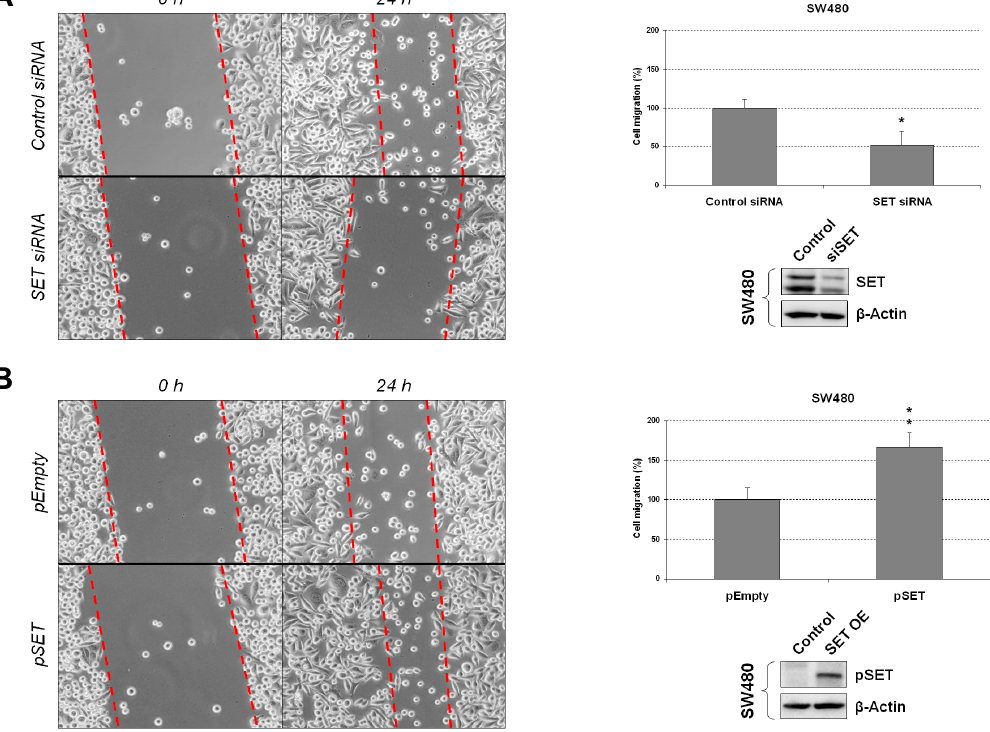
Figure 1. SET modulates cell migration in colorectal cancer (CRC) cells. Wound-healing assay showing migration in SW480 cells after ectopic ( A ) SET silencing or ( B ) SET overexpression. Dashed lines represent the migration border; OE: Overexpression; * p < 0.05; ** p < 0.01.